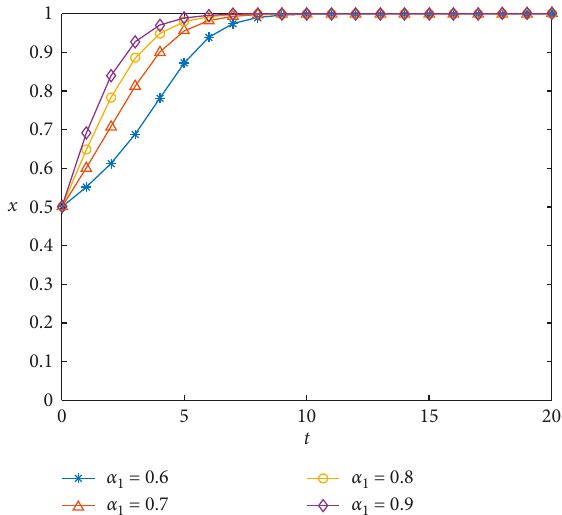
Figure 8: Influences of the ratio of the input to the output α